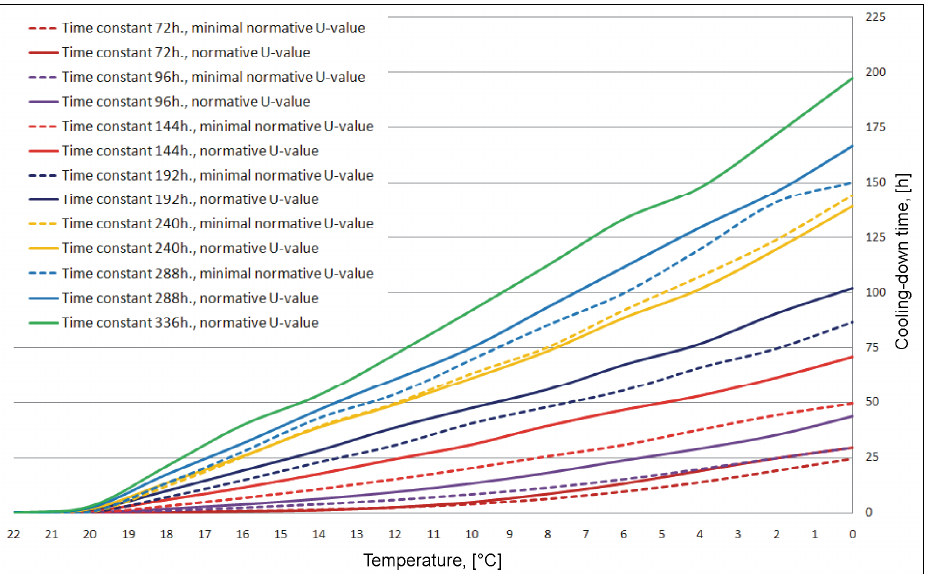
Fig. 3. Curves of building cooling-down at “average” outdoor temperature conditions